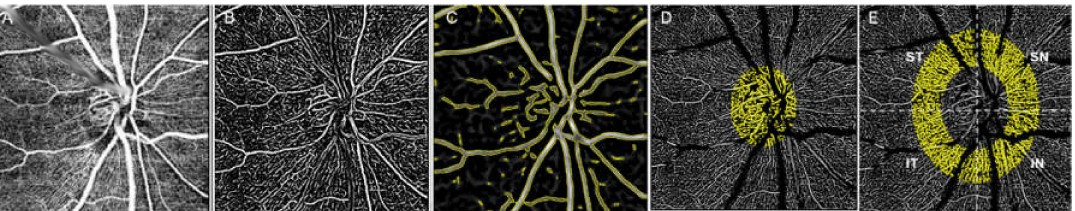
Figure 1. Measurement of vascular density: ( A ) En face, optical coherence tomography angiography image of 3 × 3-mm 2 disc area showing vessels from two combined layers; ( B ) Vessels were traced using Frangi vesselness plug-in; ( C ) Large vessel areas were selected using Tubness plug-in. Regions of interest were selected in the optic disc ( D ) and peripapillary area ( E ). Vascular density was calculated by dividing vessel area by region of